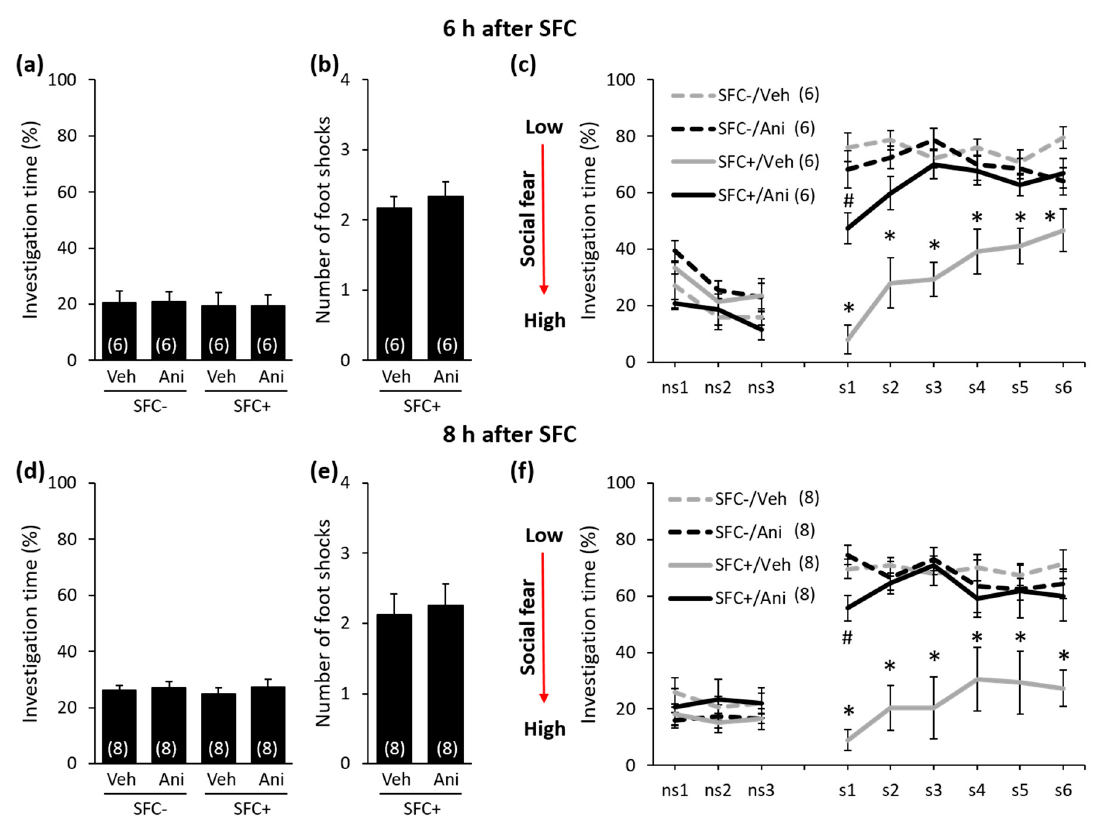
Figure 3. Anisomycin impairs the consolidation of social fear memory when administered 6 h or 8 h after social fear conditioning (SFC). ( a , d ) Pre-conditioning investigation of the non-social stimulus (empty cage) shown by unconditioned and conditioned (SFC − and SFC + , respectively) mice during SFC on day 1. ( b , e ) Number of foot shocks received by SFC + mice during SFC. ( c , f ) Investigation of the non-social (ns1–ns3) and social (cages with mice; s1–s6) stimuli during social fear extinction on day 2. Mice were injected intraperitoneally either with vehicle (Veh; 0.9% saline; 5 mL / kg) or anisomycin (Ani; 150 mg / kg) 6 h or 8 h after SFC. Data represent mean ± SEM and numbers in parenthesis indicate group sizes. p < 0.05 * versus all groups; # versus SFC + /Veh and SFC − /Ani.